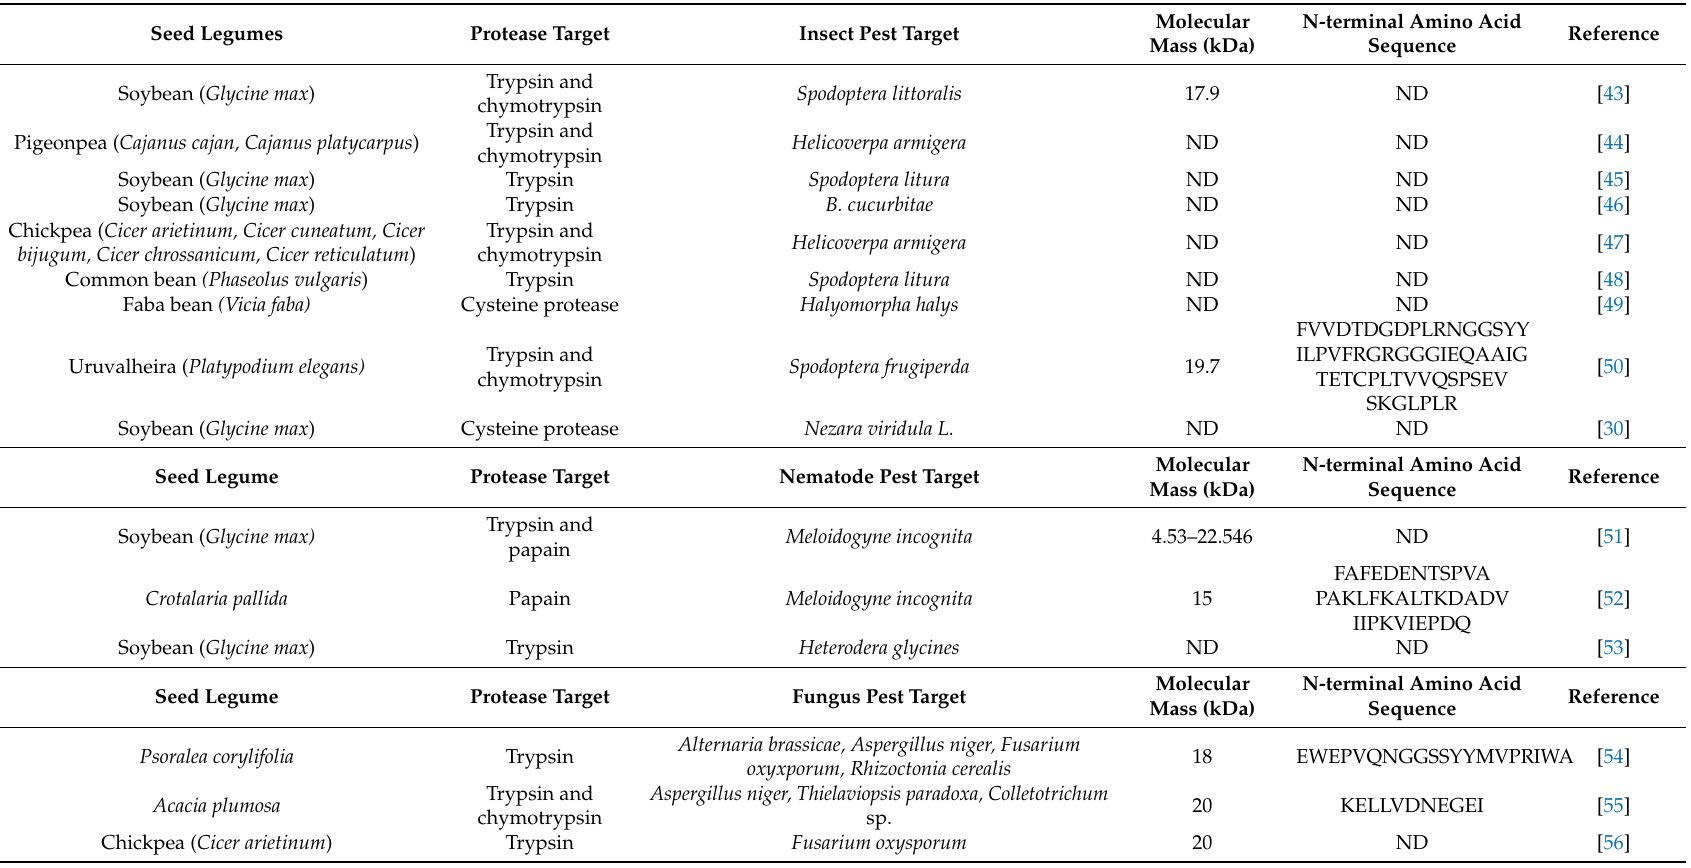
Table 2. Legumes protease inhibitors (PIs) reported e ff ective against phytopathogenic insects, nematodes, and